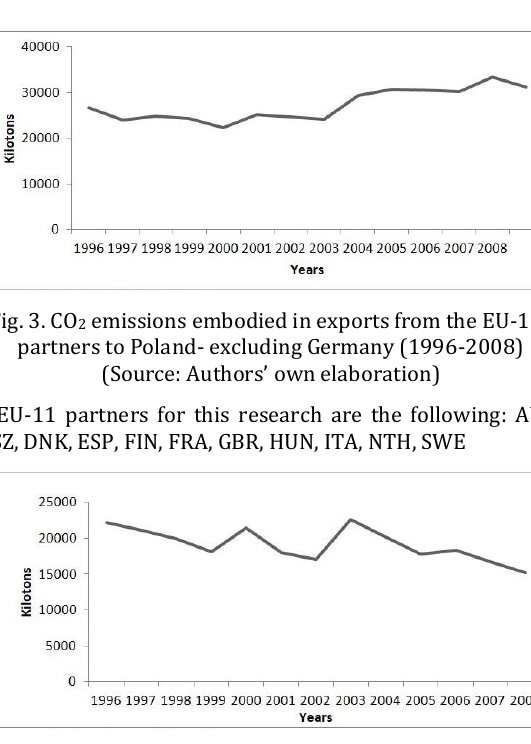
Fig. 4. CO 2 emissions embodied in exports from Poland to Germany (1996-2008) (Source: Authors’ own elaboration)